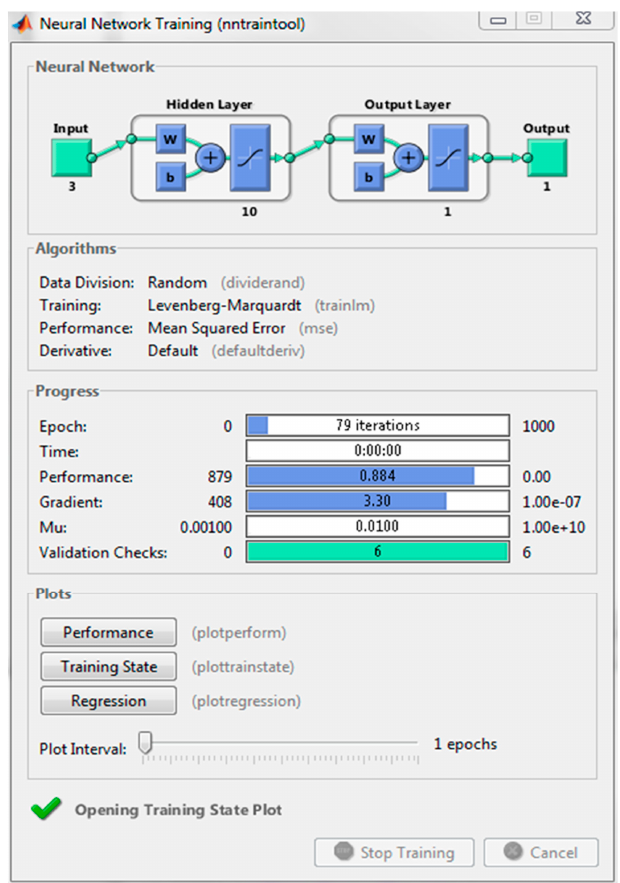
Figure 2. ANN toolbox indicating learning process and operational